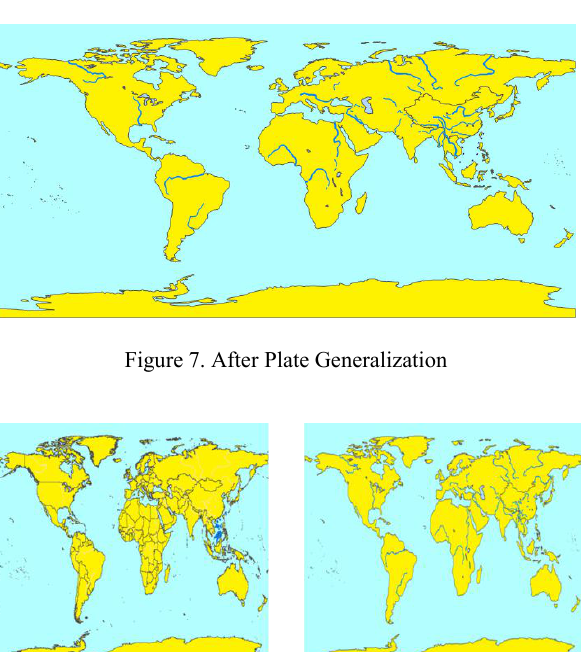
Figure 6. Before Plate Generalization